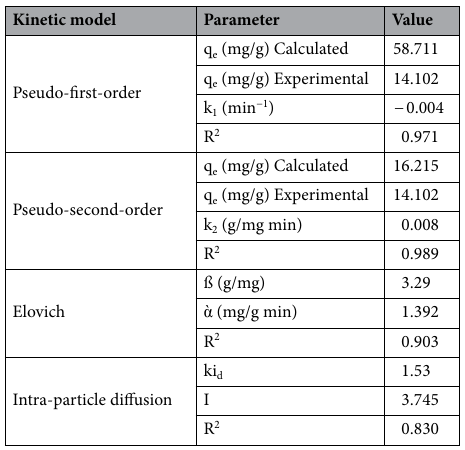
Table 8. Parameters for the biosorption of MB dye onto the used P. alcaliphila NEWG-2 bio-sorbent material obtained from different kinetic